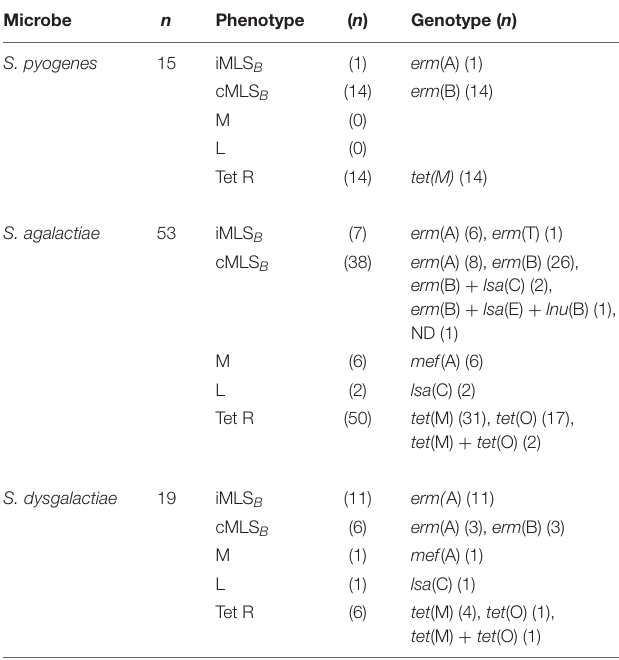
TABLE 2 | Antimicrobial resistance phenotype and genotype of the macrolide and lincosamide resistant β -hemolytic streptococcal isolates. Microbe